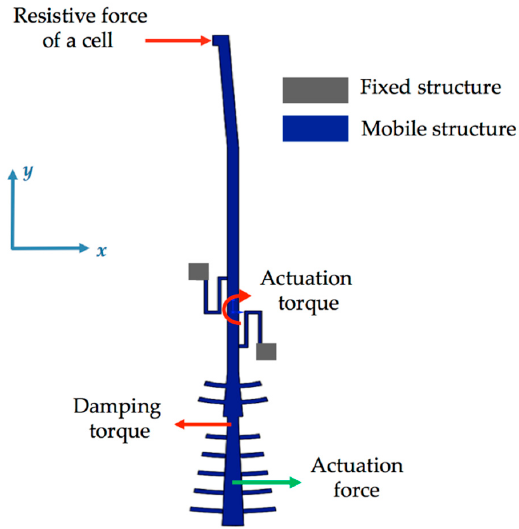
Figure 6. Free body diagram of the forces and torsional moments on the mobile arm of the microgripper.